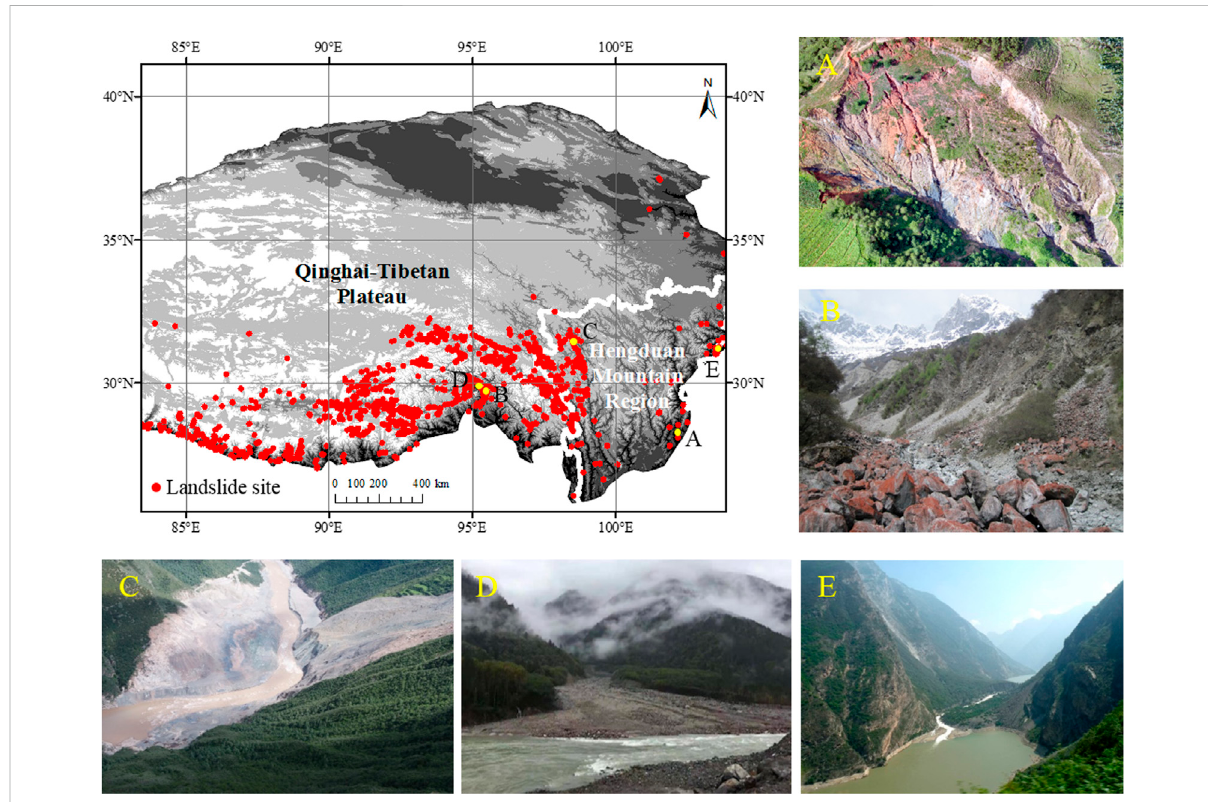
FIGURE 1 Regional topography and landslide sites of the eastern and south-eastern margin of the Qinghai-Tibetan Plateau, and nature hazard: (A) rapid stream bed incision (Fencha Gully, photo by Kehan Huang in December 2020); (B) collapse (Guxiang Gully, photo by Liqun Lyu in May 2015); (C) landslides (Jinsha River, photo by Yunlong Lei in October 2019); (D) debris fl ow (Palong River, taken by Kehan Huang in October 2019); (E) landslide dam (Diexi landslide, photo by Zhaoyin Wang in